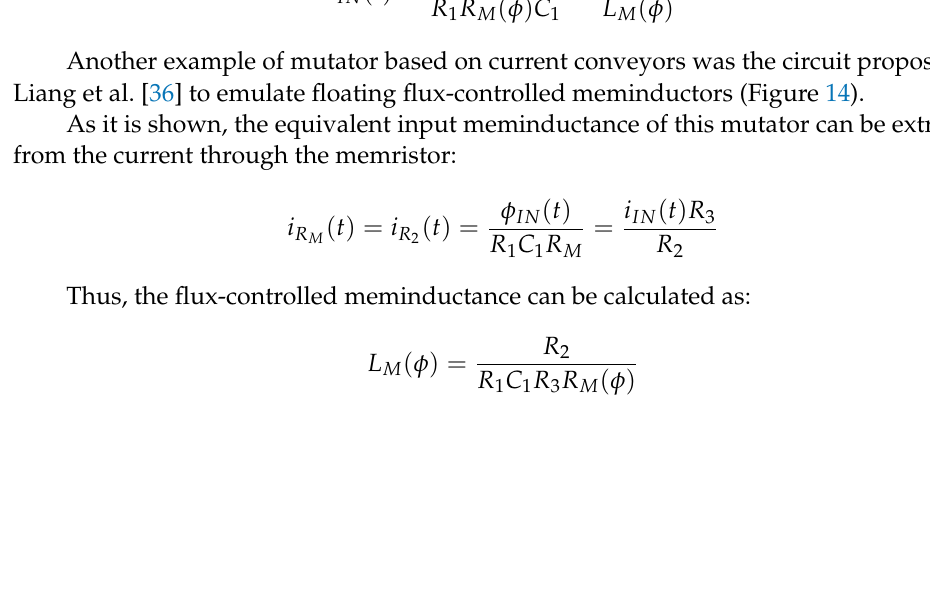
Figure 13. Meminductor emulator circuit based on current conveyors proposed by Sah et al. [52] .